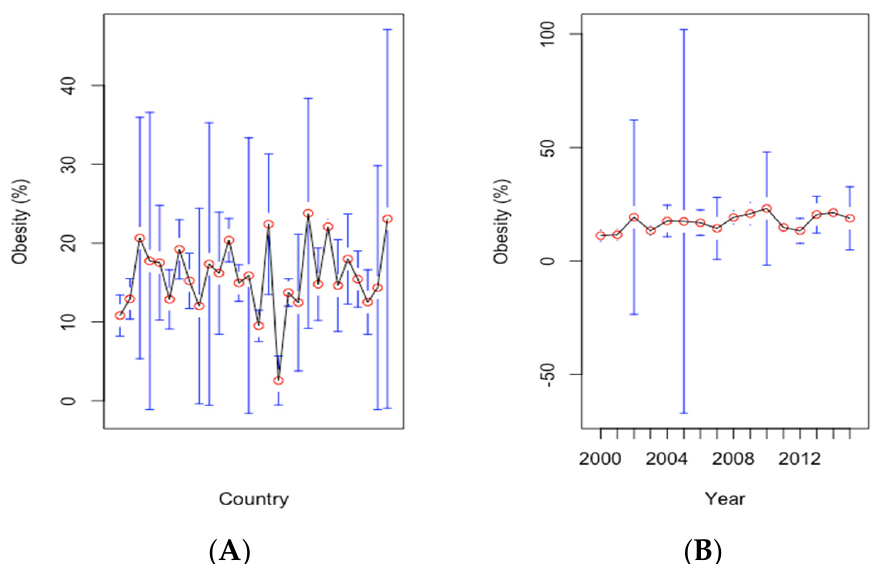
Figure 4. Mean prevalence of obesity (%) by country, including the confidence intervals (Panel A ). The evolution of mean prevalence of obesity from 2000 to 2015, with confidence intervals (Panel B ). Source of data: World Bank’s Development Indicators (WDI) database. Table 4. The correlogram of the